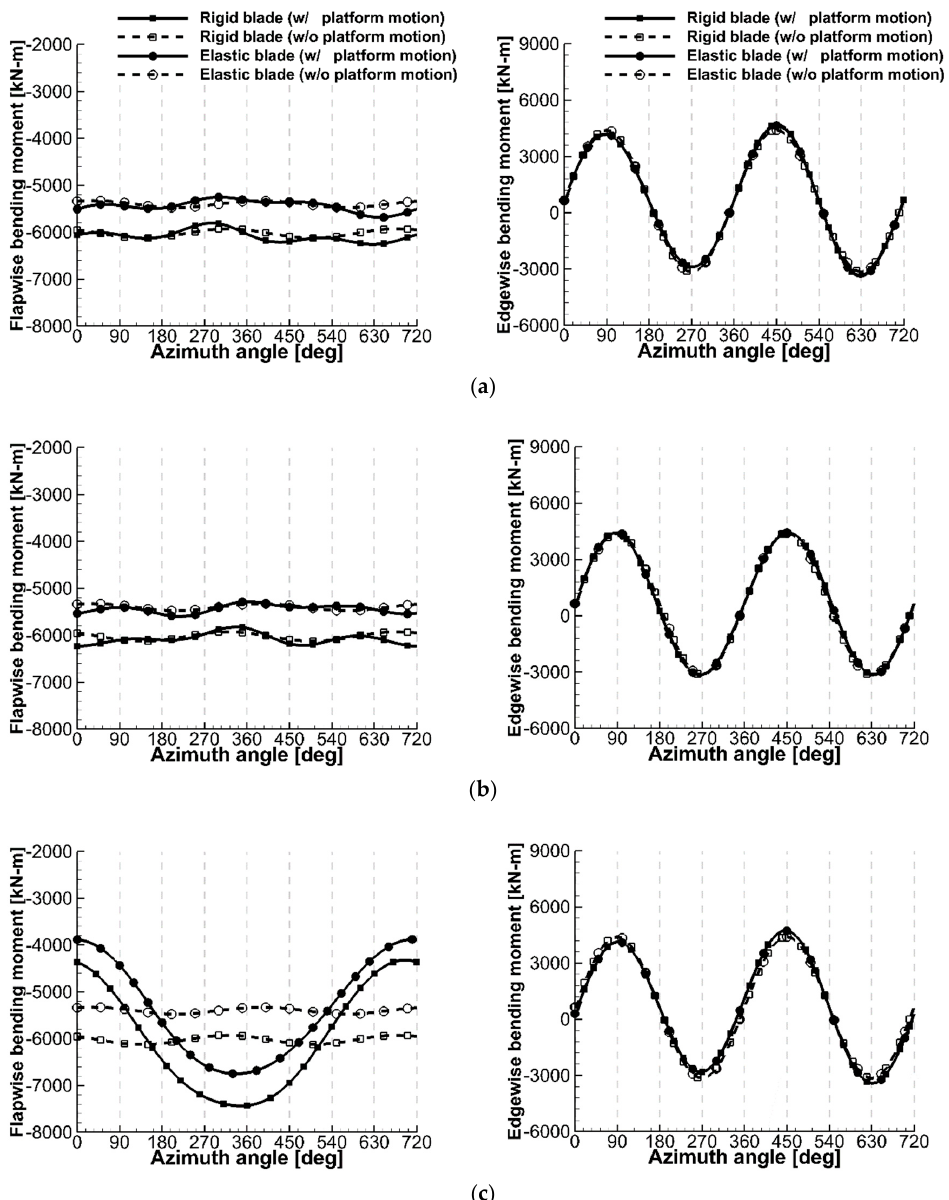
Figure 12. Blade root bending moments under translational platform motions. ( a ) Heave motion. ( b ) Sway motion. ( c ) Surge